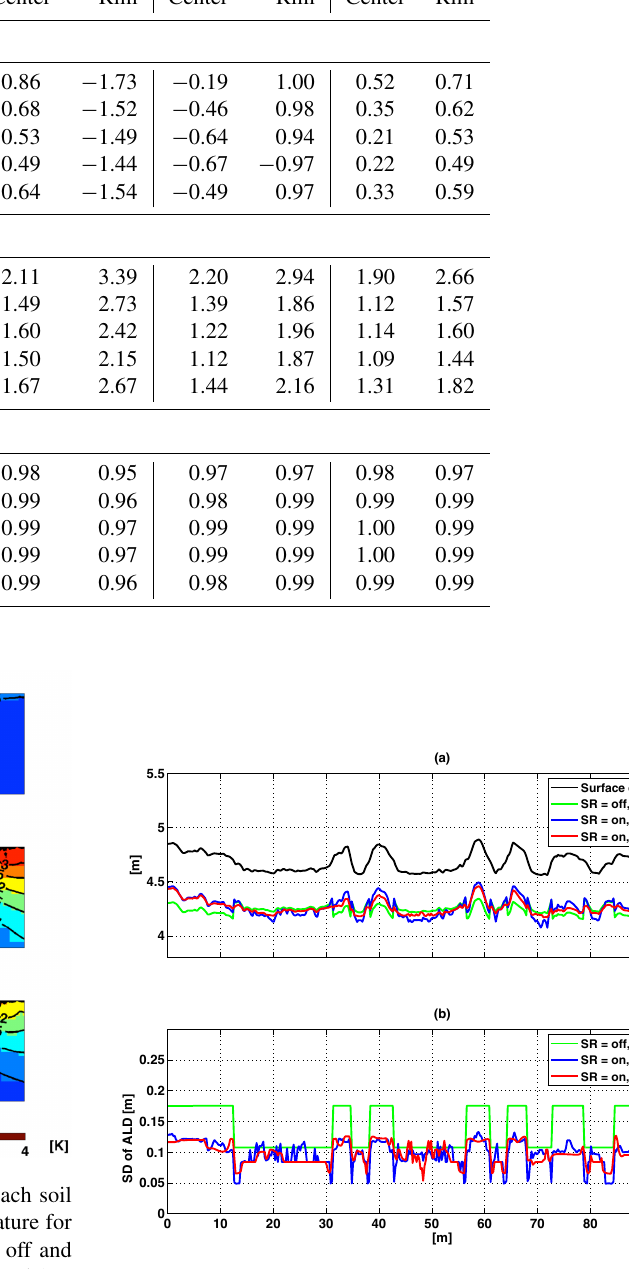
Figure 7. Temporal mean of the bottom of the active layer (a) and standard deviation of the active layer depth (b) over the 10-year period across the modeling